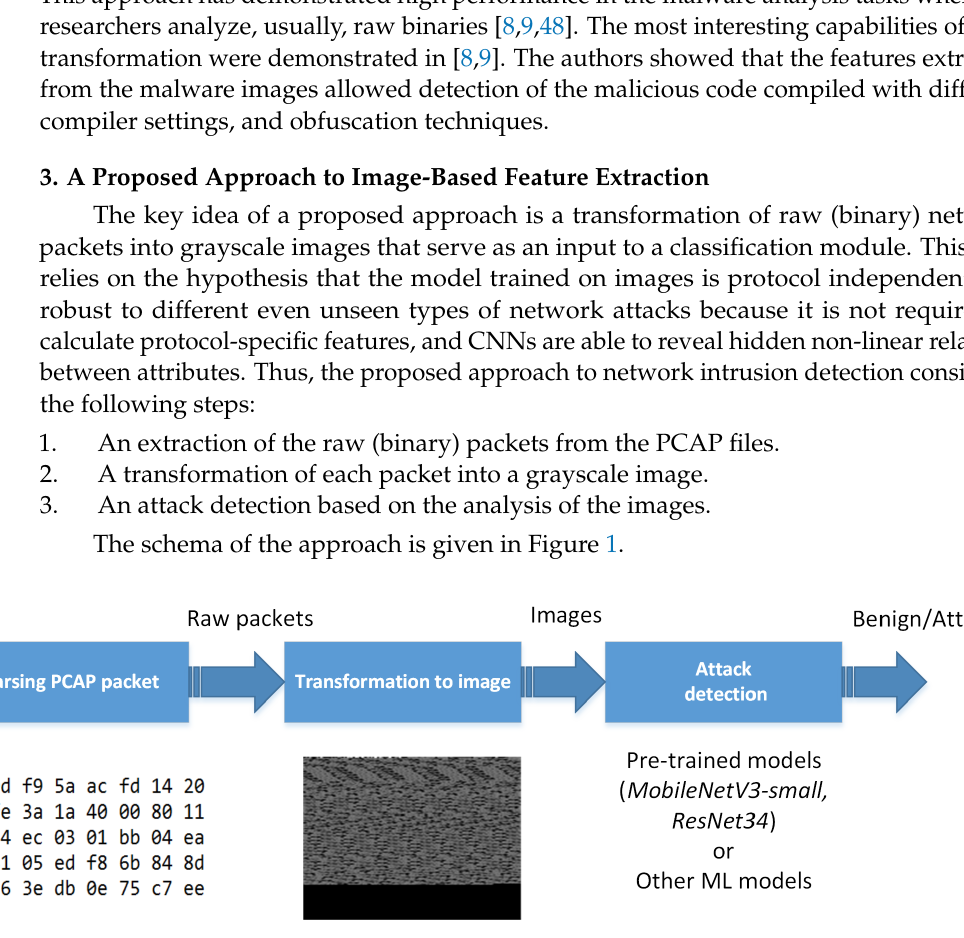
Figure 1. Generic schema of the intrusion detection using image-based